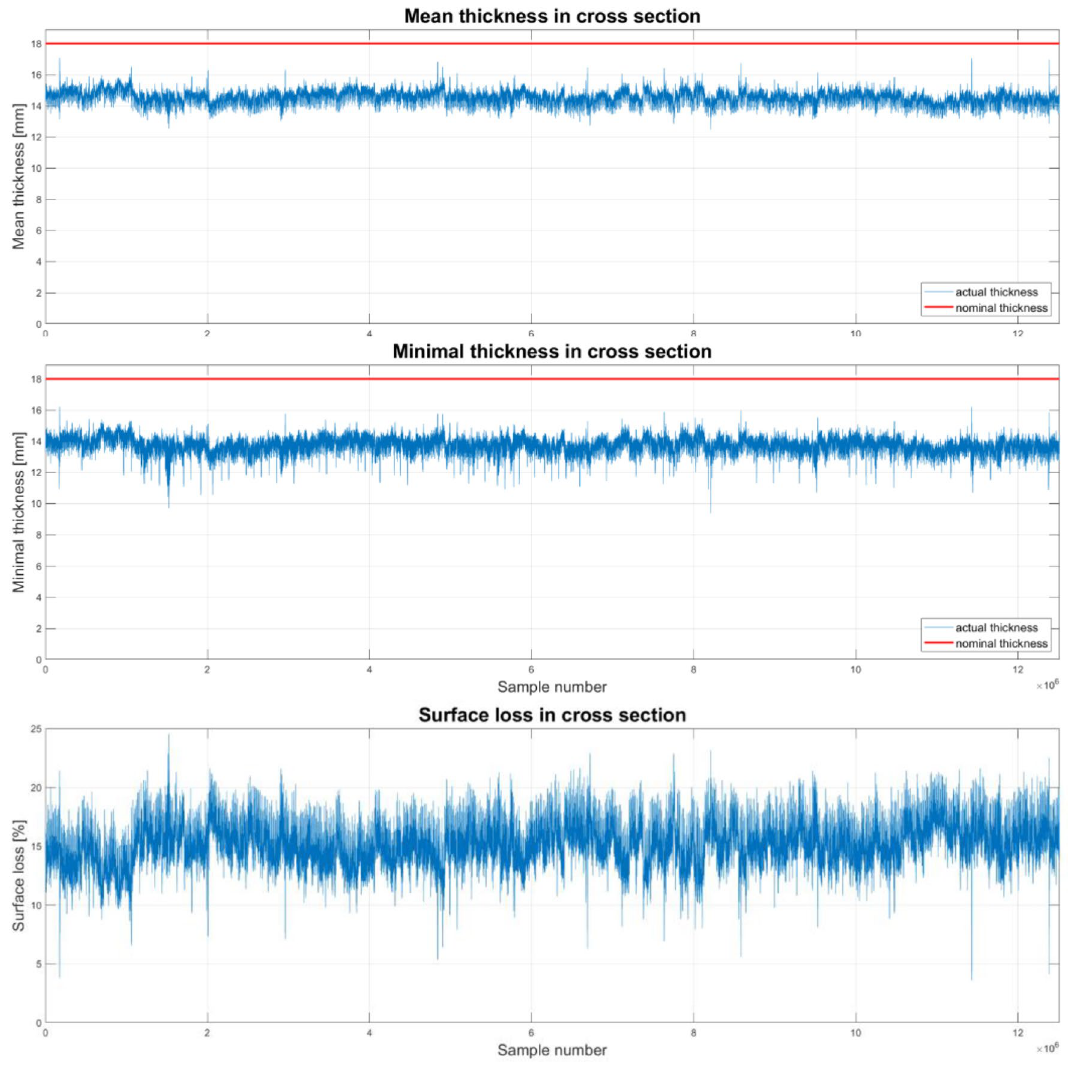
Figure 9. Parameters of the cross-section along the length of the belt—device prototype testing.